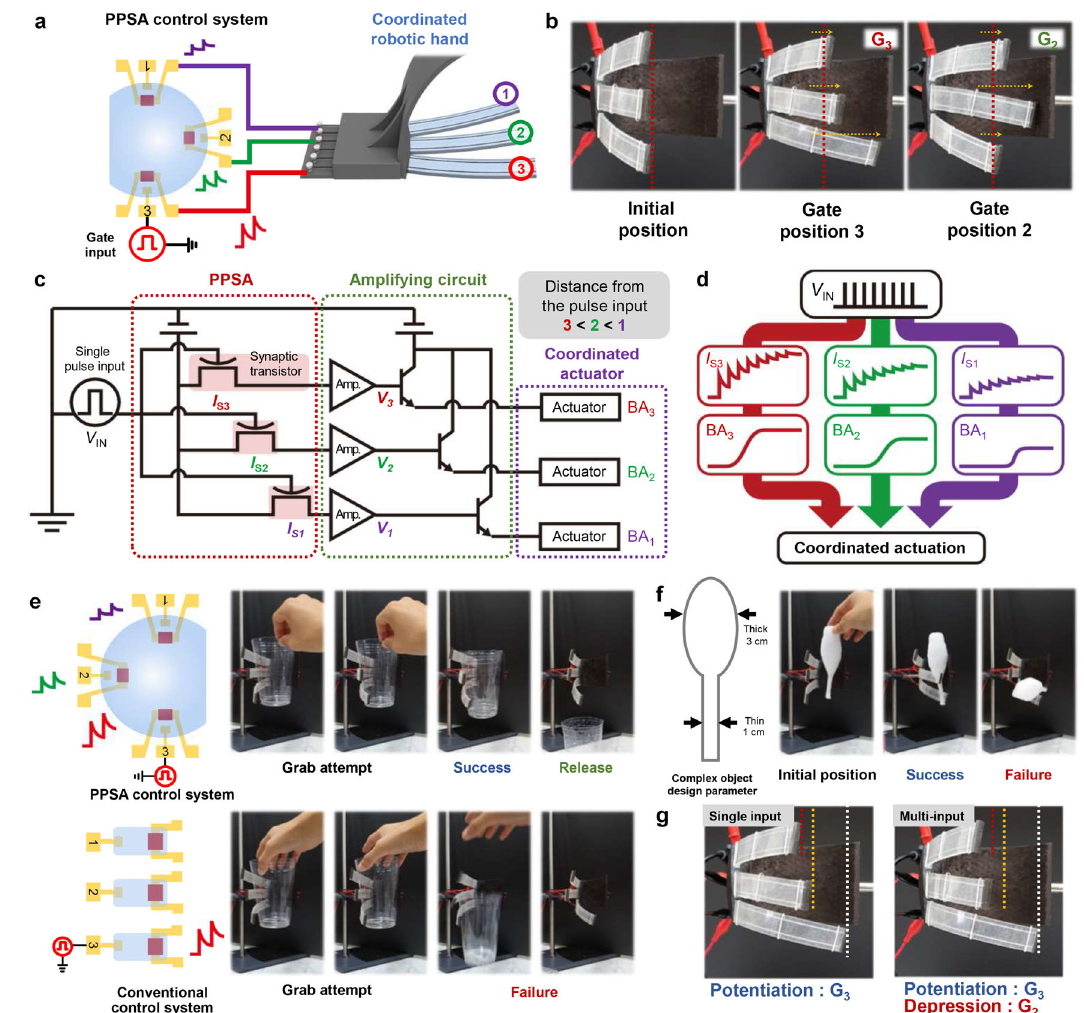
Fig. 4 | CRH control with PPSA. a Schematic illustration of connection between PPSA control system and CRH. b Photographic image of coordinated actuation under varying applied input position. c Circuit diagram of coordinated actuation system. d Schematic illustration of signal fl ow of coordinated actuation. e Comparisonof cup grabbing performancebetween the PPSAcontrol system and